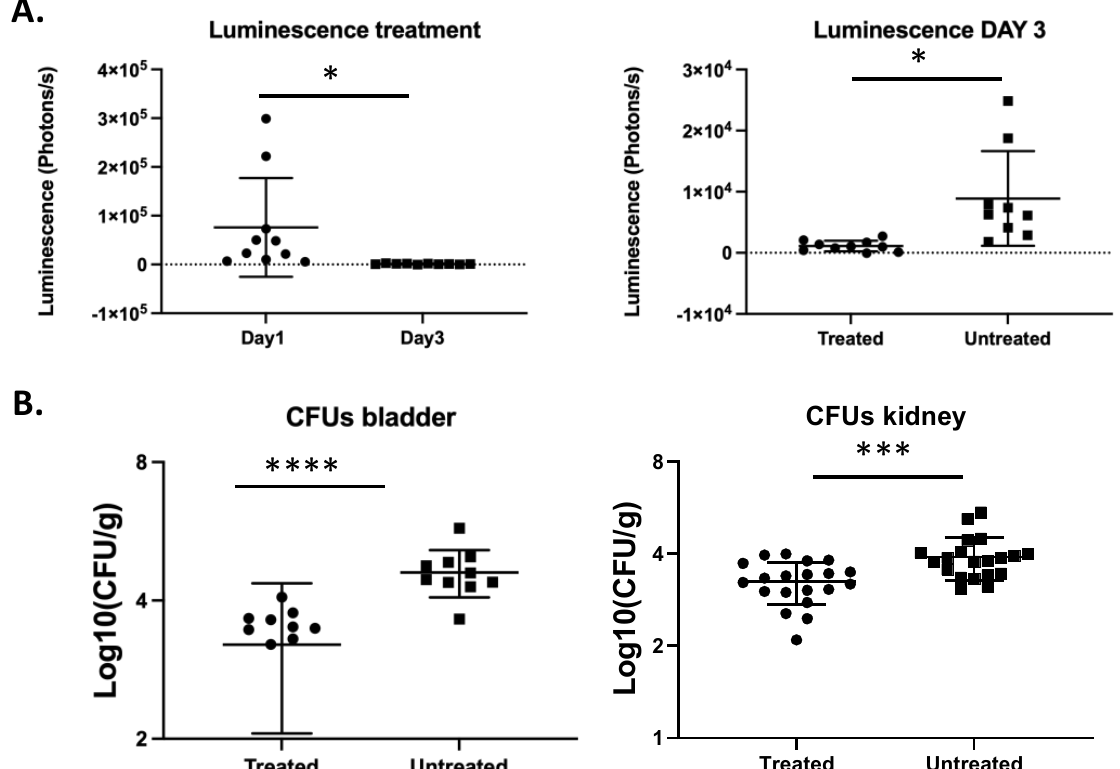
Figure 5. Bioluminescence imaging reflects the decreased fungal burden because of antifungal treatment. Ten mice per group were infected with 2.5 × 10 8 C. glabrata cells directly into the bladder. The treated group was injected intraperitoneally with fluconazole (50 mg/mL) on a daily basis. Luminescence in the bladders was measured on day one and three post infection. ( A ) Luminescence in the bladders upon fluconazole treatment (paired t -test, p = 0.0439) ( left ). Luminescence in the bladders of treated mice is significantly lower compared to untreated mice (unpaired t -test, p = 0.0167) ( right ). ( B ) Fungal burden in the bladders and the kidneys upon fluconazole treatment (unpaired t -test, p < 0.0001 and p = 0.0007, respectively). All error bars show standard deviations. Significance: **** p < 0.0001, *** p < 0.001, * p < 0.05.